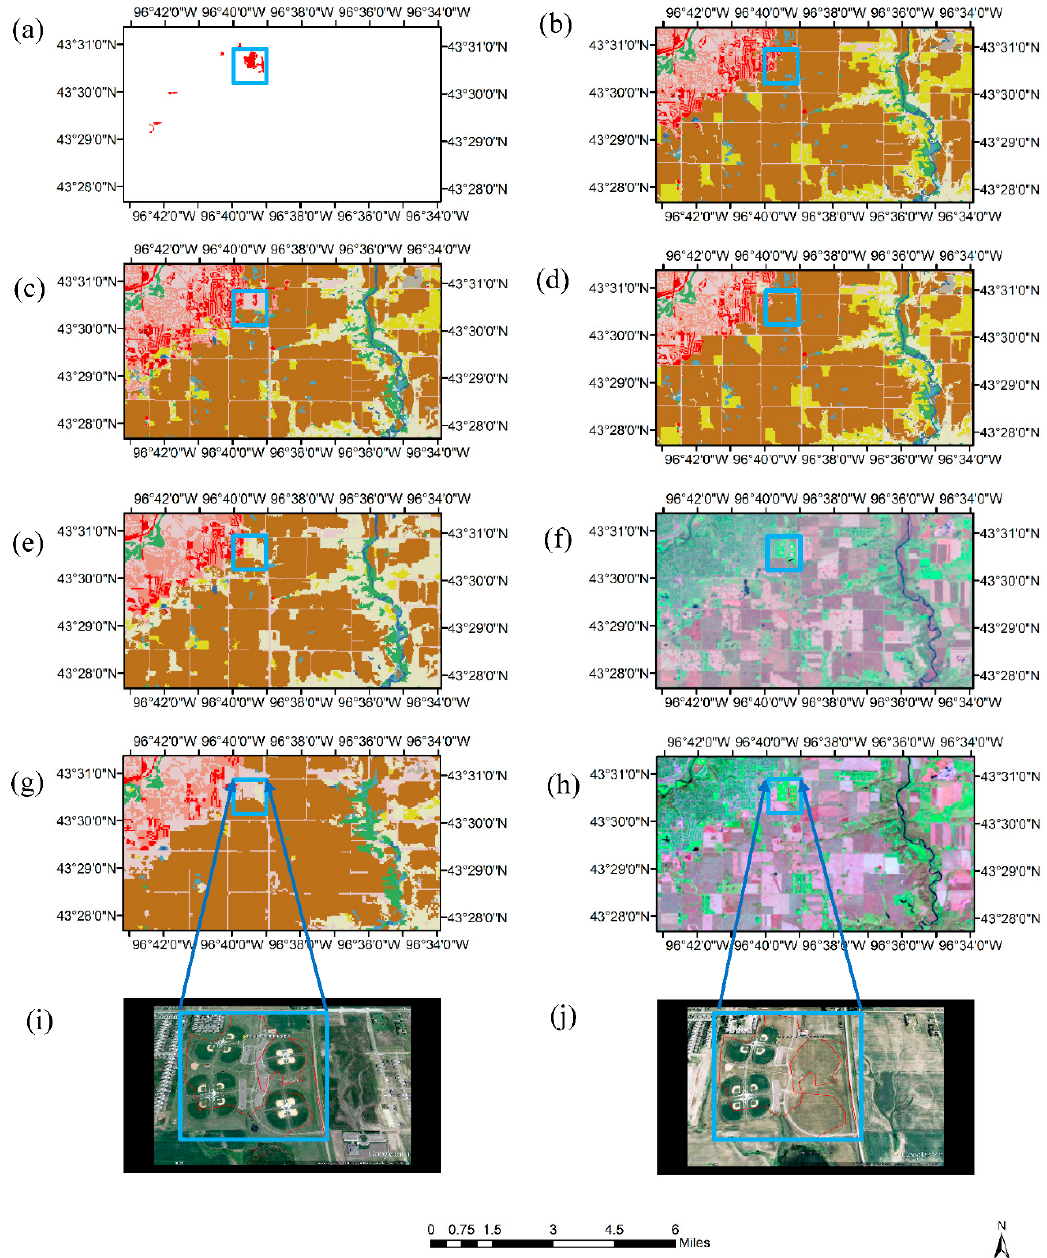
Figure 5. Provides an interpretation example and the corresponding datasets and images used. Based on the reference data, we compared the commission and omission error identified by the model of each sample unit to the corresponding reference data: ( a ) commission pixels; ( b ) NLCD 2006; ( c )